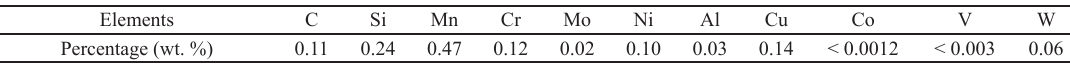
Table 1. Chemical composition of ordinary steel